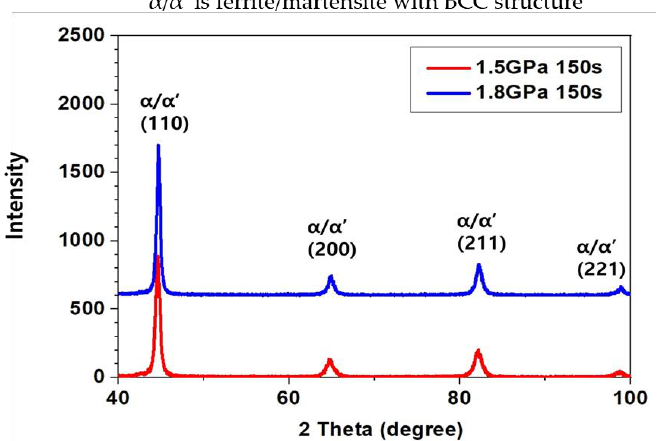
Figure 3. Results of X-ray diffraction of martensitic phase on the 1.5 GPa and 1.8 GPa grade steels austenitized for 150 s at 1203 K; The indication of α/ α’ means ferrite/ martensite with body centered (bcc) structure (bcc)